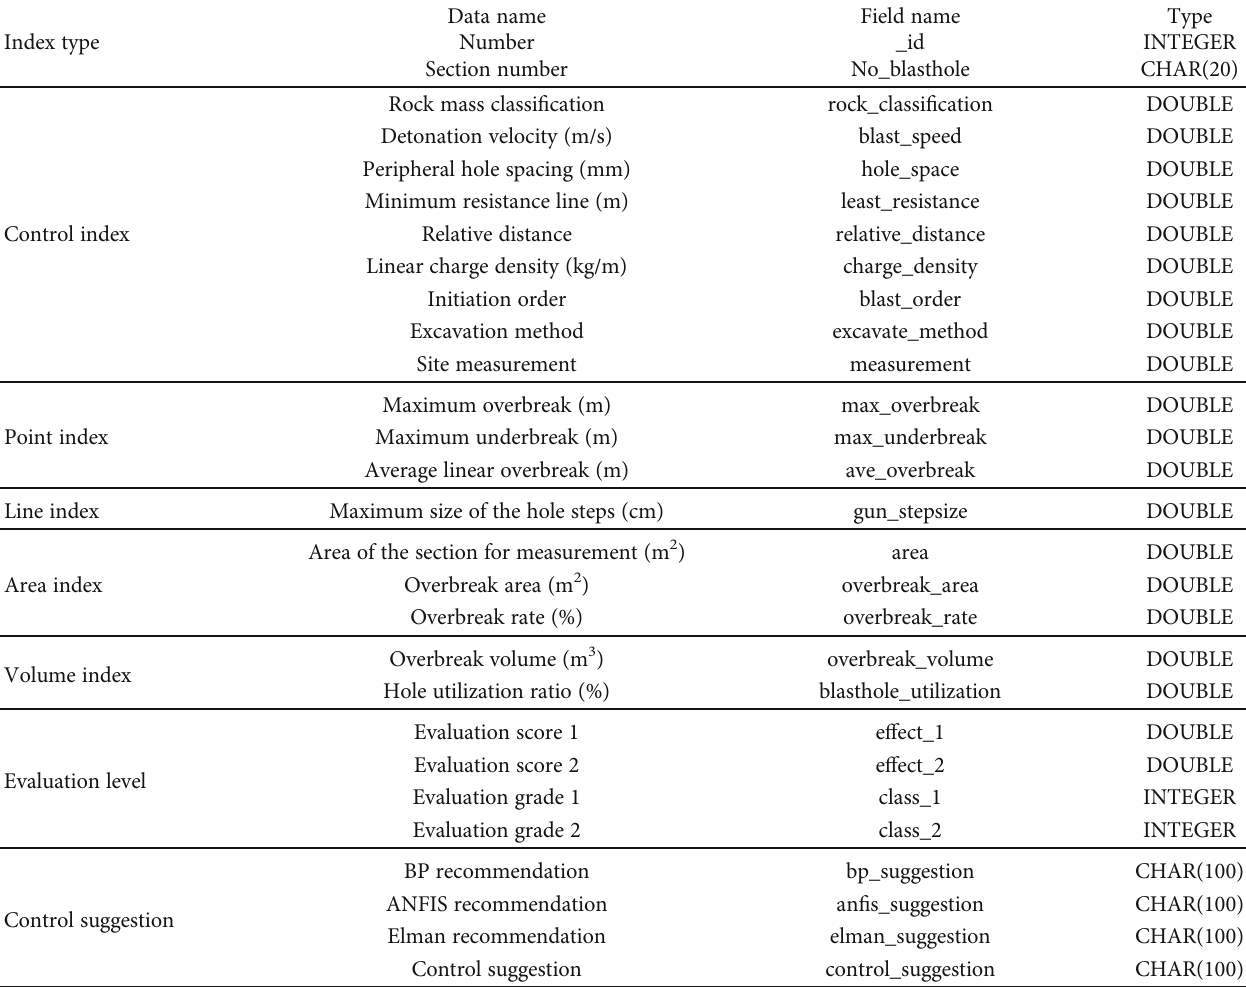
Table 1: Set of data types of the